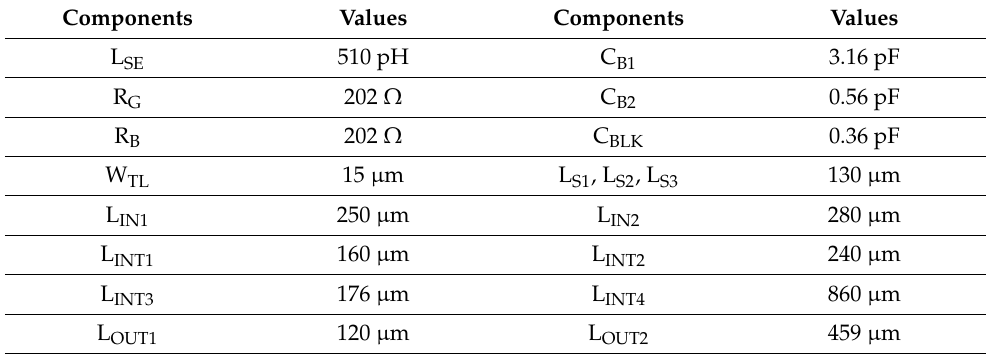
Table 2. Values of the utilized components.